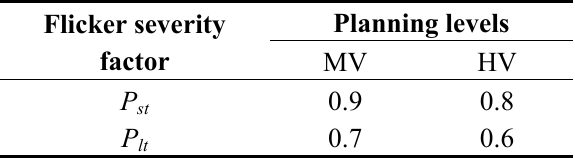
Table 1. Flicker planning levels for medium voltage (MV) and high voltage (HV) networks.